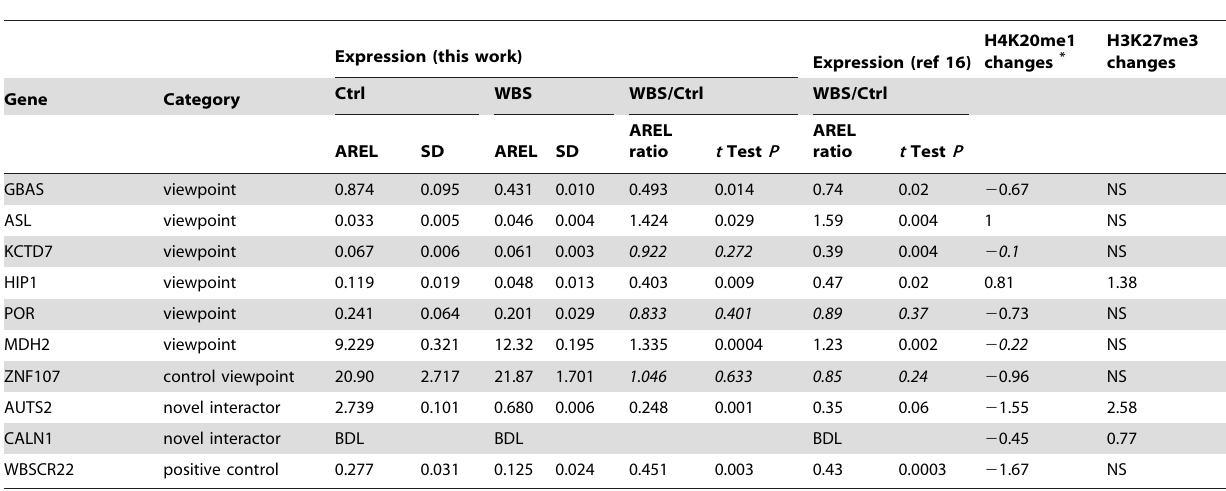
Table 1. Expression changes and chromatin architecture modifications in WBS